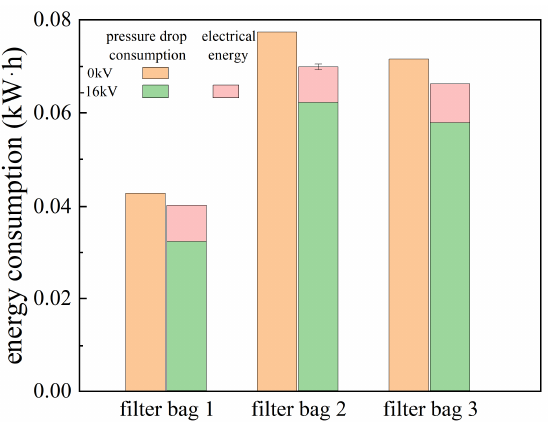
Figure 10. Comparison of energy consumption of three types of filter bags under different experi- mental conditions.